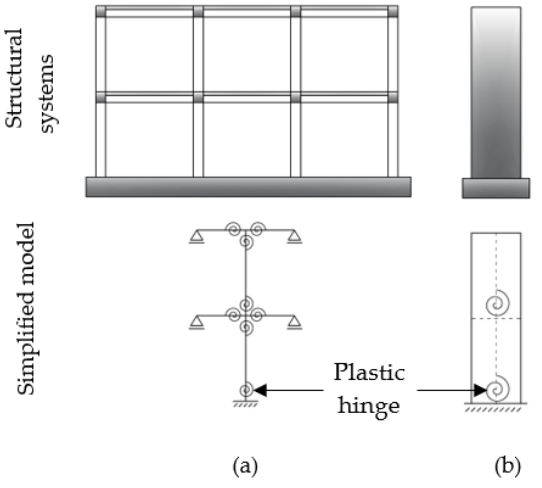
Figure 1. Schematic presentation of transition from ( a ) frame building to IFB model and ( b ) cantilever wall to elastic beam-column element with plastic hinges.